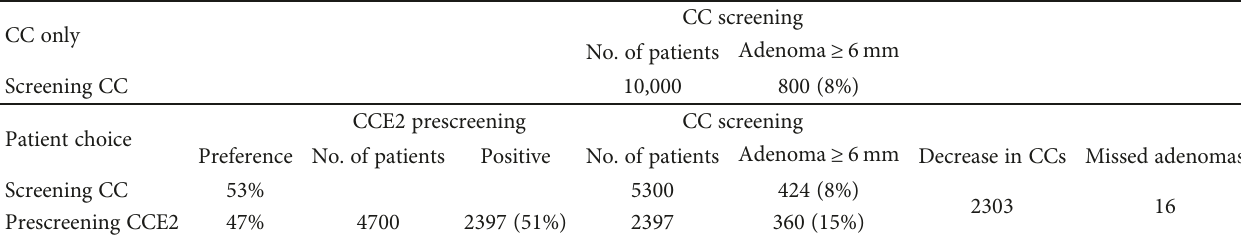
Figure 3: ROC curve comparing false-positive and true-positive rates (considering con fi rmed adenomas larger than 6 mm as the endpoint) at di ff erent levels of CCE2 polyp size cut-o ff s for referral to OC. Sp: speci fi city, Se: sensitivity, NPV: negative predictive value. Table 5: Simulation model comparing the outcomes for a cohort of 10,000 individuals undergoing either screening colonoscopy (CC) only or the choice of the screening test of CC or CCE2 (high-speci fi city cut-o ff ). Model parameters (patient preference, CCE2 positivity, and pre- and post-CCE2 adenoma prevalence) were taken from this